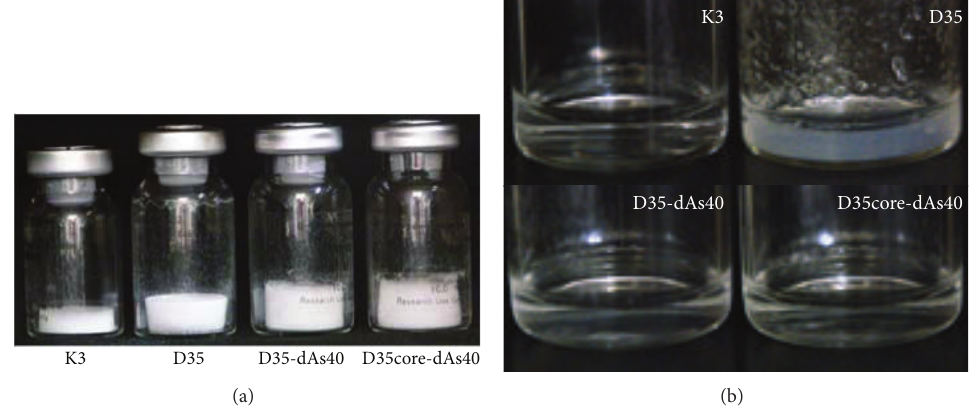
Figure 8: D35-dAs40 and D35core-dAs40 but not original D35 are directly solubilized in saline. (a) GMP grade lyophilized ODN vials (10mg/vial) of K3, D35, D35-dAs40, and D35core-dAs40. White material is the lyophilized synthetic ODNs. (b) Saline (1mL) was directly added to each vial. K3, D35-dAs40, and D35core-dAs40 were completely solubilized in saline at 5 min. D35 was not completely dissolved in saline with many visible gelatinous aggregations, and this insolubilized status was unchanged for at least 1